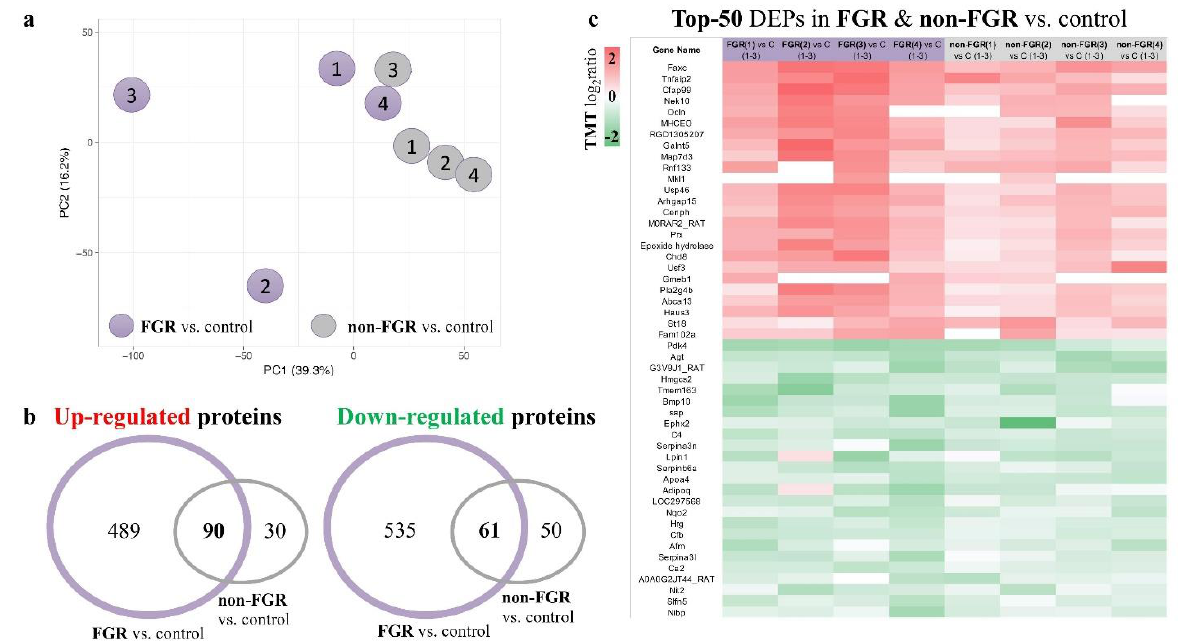
Figure 1. ( a ) Principal component analysis (PCA) of all quantified proteins demonstrated that hearts of fetal growth- restricted (FGR) neonates had a distinct and more heterogeneous proteomic profile compared to non-FGR ones. ( b ) Venn diagram showing overlap of differentially expressed proteins compared to controls in FGR and non-FGR groups. ( c ) Heatmap of top-50 common differentially expressed proteins in both FGR and non-FGR groups vs. control.